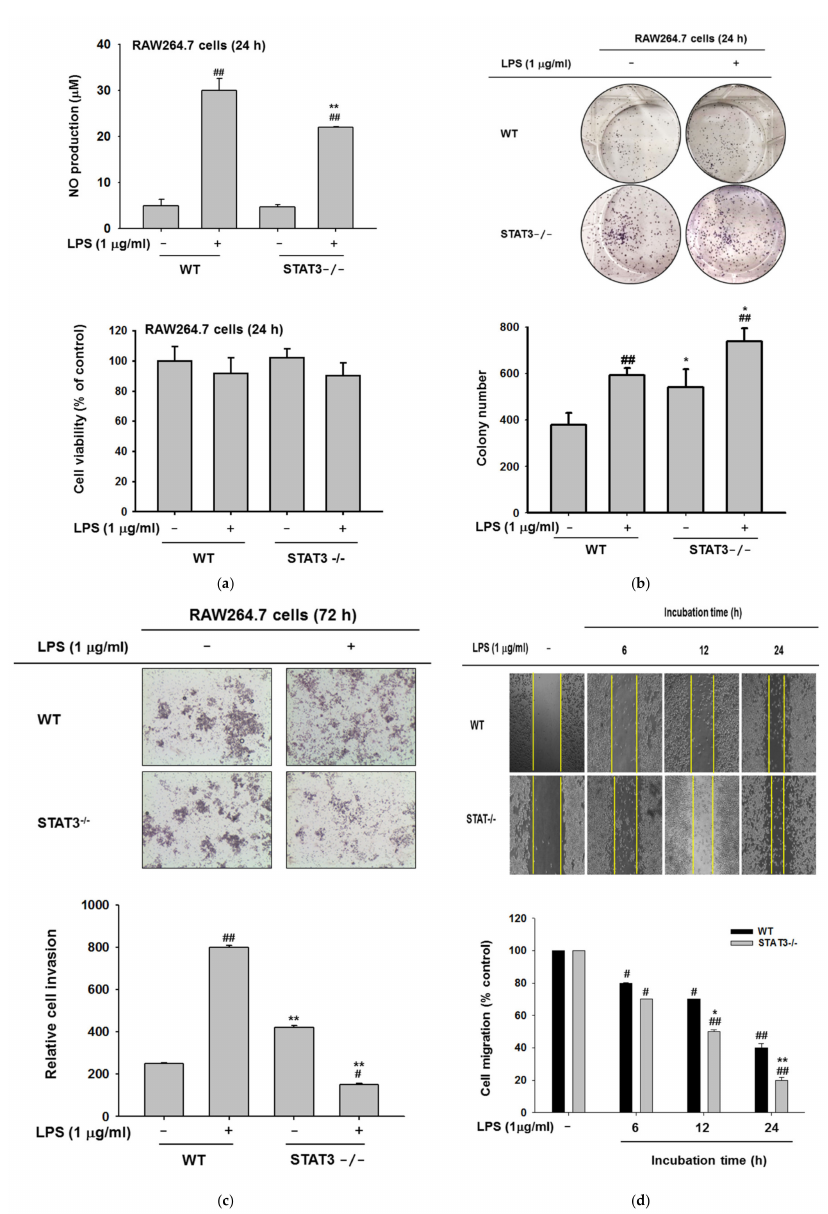
Figure 4. STAT3 deletion impacts NO production, macrophage colony formation, invasion, and cell migration. ( a ) Wild type and STAT3 - / - RAW264.7 cells were incubated with LPS (1 µ g / mL) for 24 h, and NO production was determined by the Griess assay and cell viability was measured using the MTT assay. ( b ) Wild type and STAT3 - / - cells were subjected to a clonogenic assay. Colonies were allowed to form for nine days and cells were left untreated or incubated with LPS (1 µ g / mL) for 24 h. Representative images of colonies are shown. Colonies were observed microscopically, and quantification of the number of colonies is shown. ( c ) Wild type and STAT3 - / - RAW264.7 cells (5 × 10 4 ), either untreated or incubated with LPS (1 µ g / mL) were subjected to a transwell invasion (with Matrigel) assay. Cell invasion was imaged under a microscope. ( d ) Cell migration assay performed in wild type and STAT3 - / - RAW264.7 cell under LPS stimulation for 6, 12, and 24 h. Representative images are shown at the indicated time points. # p < 0.05 and ## p < 0.01 compared to normal group in the same cell type and * p < 0.05 and ** p < 0.01 compared to the same condition of wild